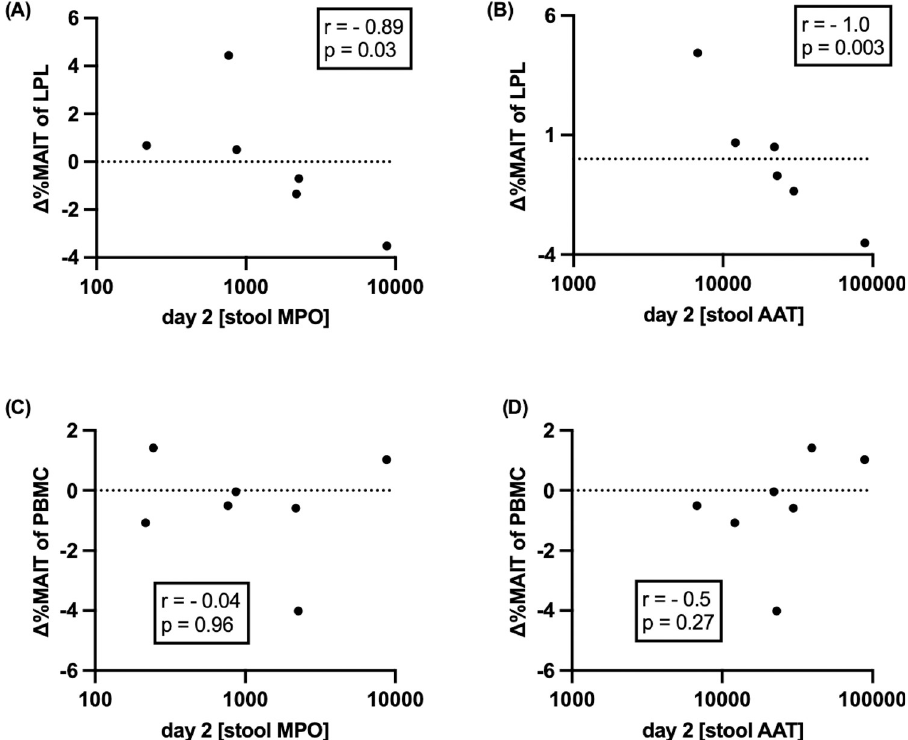
Fig 3. MAIT cell number and correlation with fecal markers of intestinal permeability (myeloperoxidase (MPO)) and inflammation (alpha-1-1antitrypsin (AAT)). Stool markers of intestinal permeability and inflammation were measured using ELISA, values were log transformed and the correlation with LPL MAIT cell number was determined using Spearman’s correlation. (A-B) shows the correlation of LPL MAITs with MPO (A) and with AAT (B), (n = 6). (C-D) shows the correlation of PBMC MAITs with MPO (C) and with AAT (D), (n = 7). [ Δ %MAIT = day30—day2% MAIT].